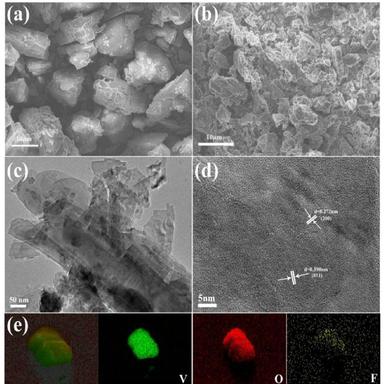
SEM images for (a) undoped sample and (b) 5 at% F doped sample; (c) TEM and (d) HRTEM images for 5 at% F, and (e) the elemental mapping of V, O and F for 5 at% F doped sample.